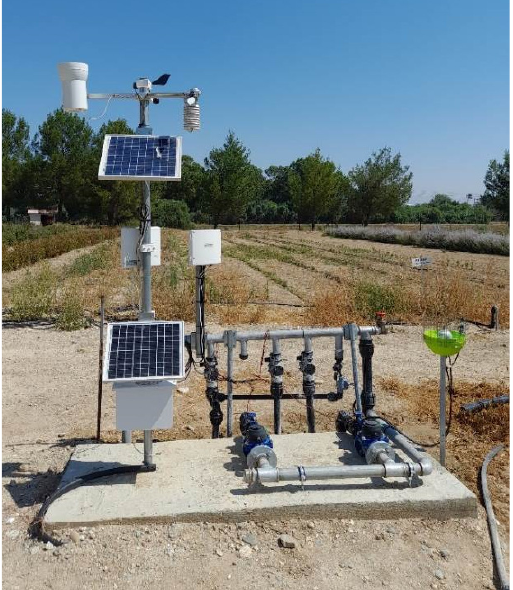
Figure 3. A Hydraulic Evapotranspiration Multisensor tested in the field, next to an agro-meteorology station.